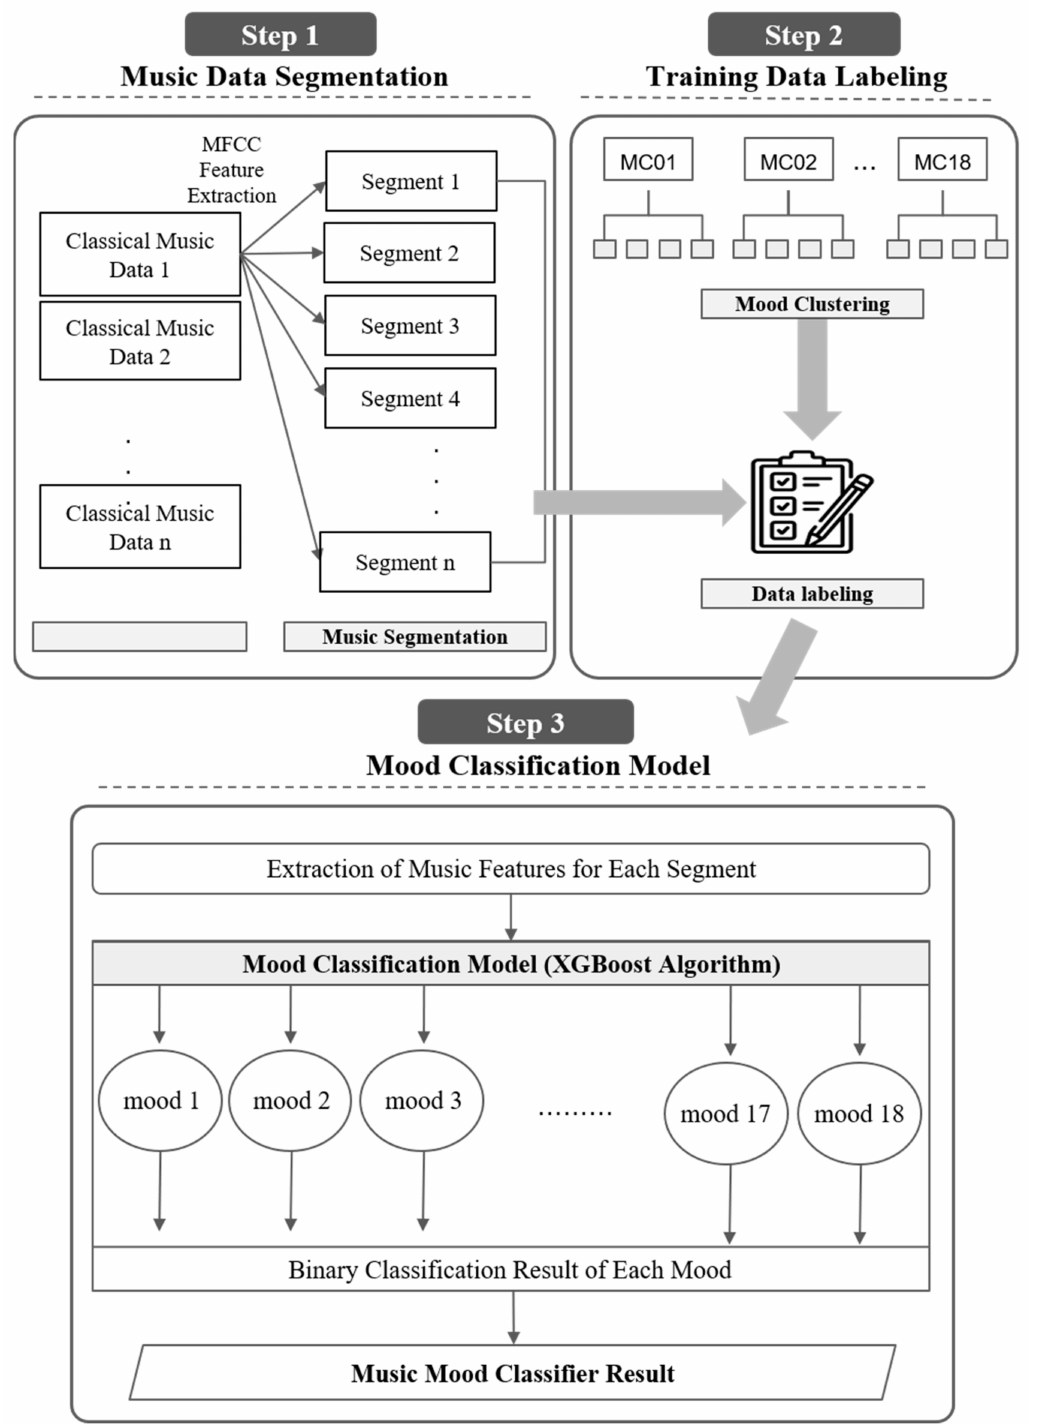
Figure 3. Introduction of Research Method per